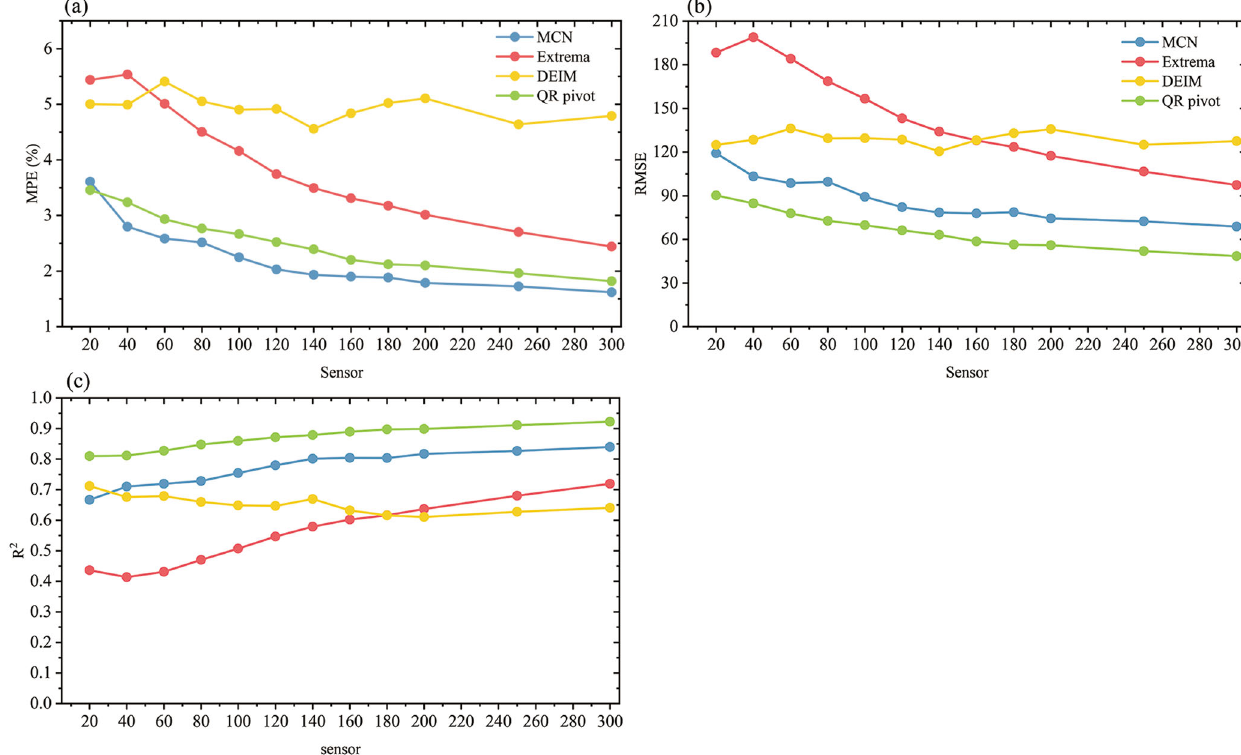
Fig. 4 Reconstruction errors with different sensor quantity. ( a ) MPE, ( b ) RMSE and ( c ) R 2 of MCN, Extrema and QR pivot with increasing numbers of sensors under the condition of P = 2 n and DEIM algorithm under the condition of P = n .